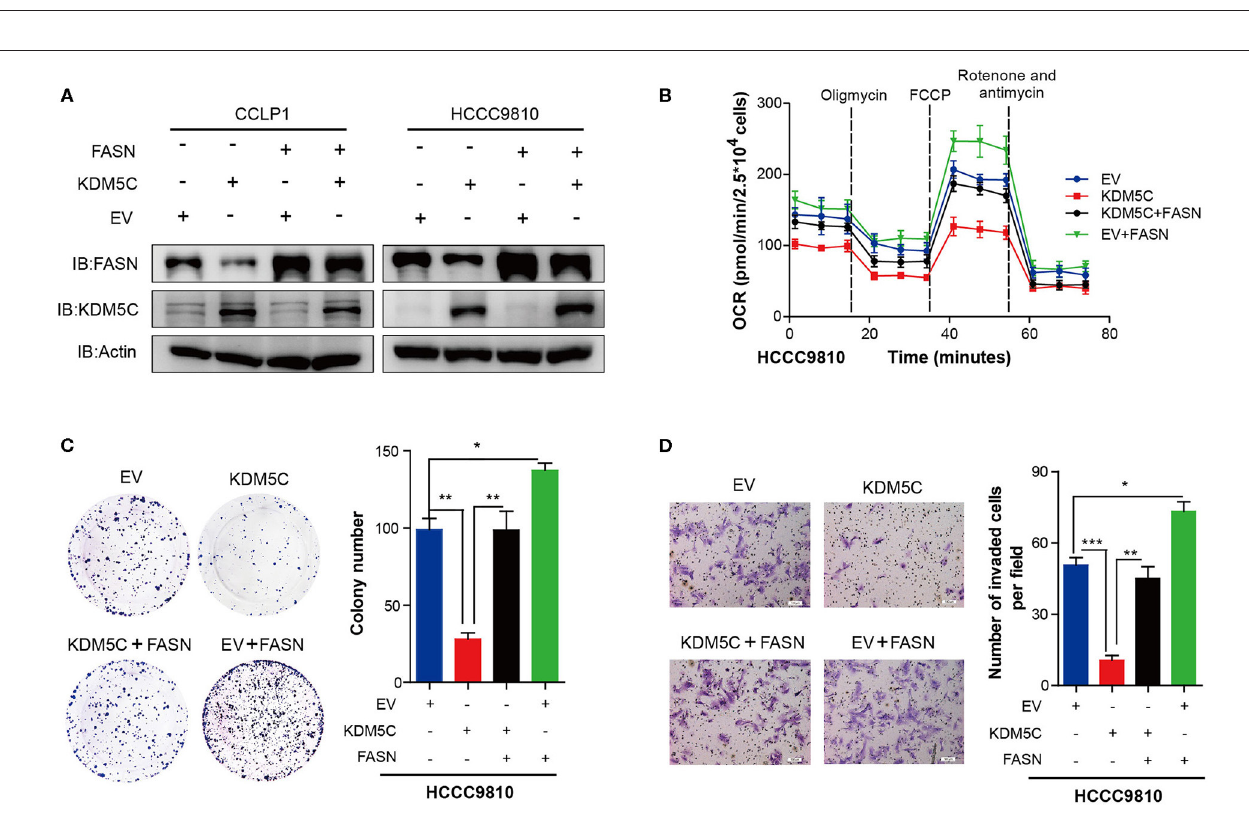
FIGURE 4 | FASN represents the major target gene of KDM5C to regulate cell proliferation and invasion. (A) Western blotting assay of FASN and KDM5C protein of FASN and/or KDM5C overexpression experiments in CCLP1 and HCCC9810 cells. (B) Oxygen consumption rates (OCR) were measured after restoration of the expression of FASN in control or KDM5C-overexpressed cells. (C) Colony formation and mean number of colonies after restoration of the expression of FASN in control or KDM5C-overexpressed cells. (D) Quantification of invaded cells after restoration of the expression of FASN in control or KDM5C-overexpressed cells were shown. Scale bars, 100 µ m. Data are presented as the mean ± SD. * p < 0.05, ** p < 0.01, *** p < 0.001. All results are from three independent